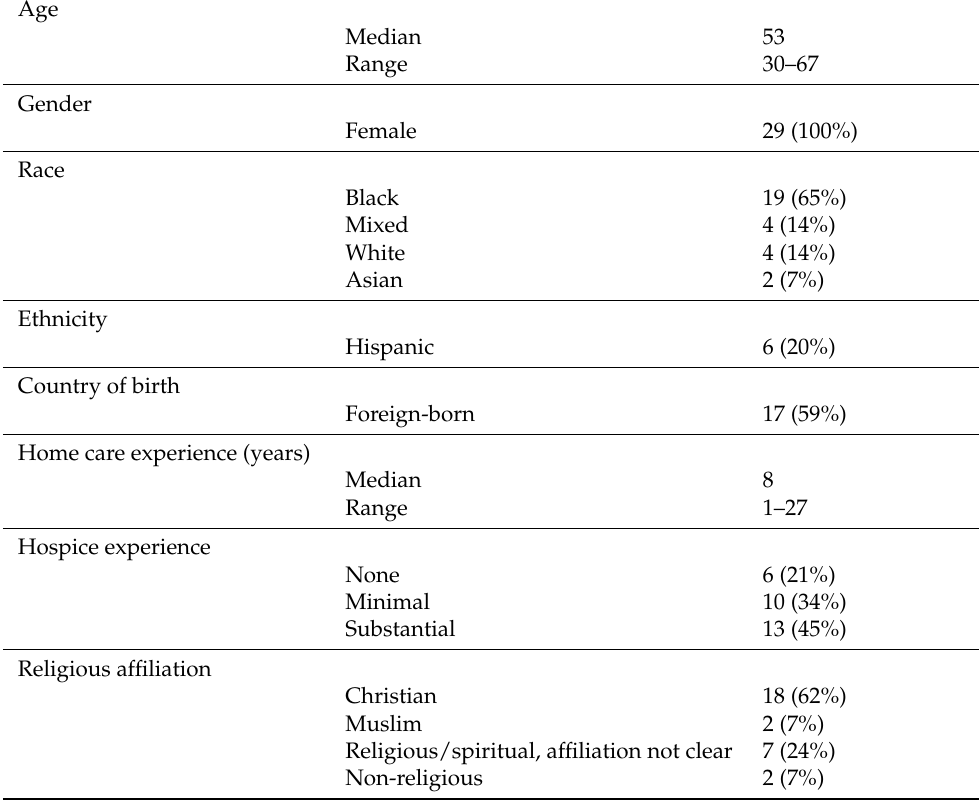
Table 1. Sample description ( n =